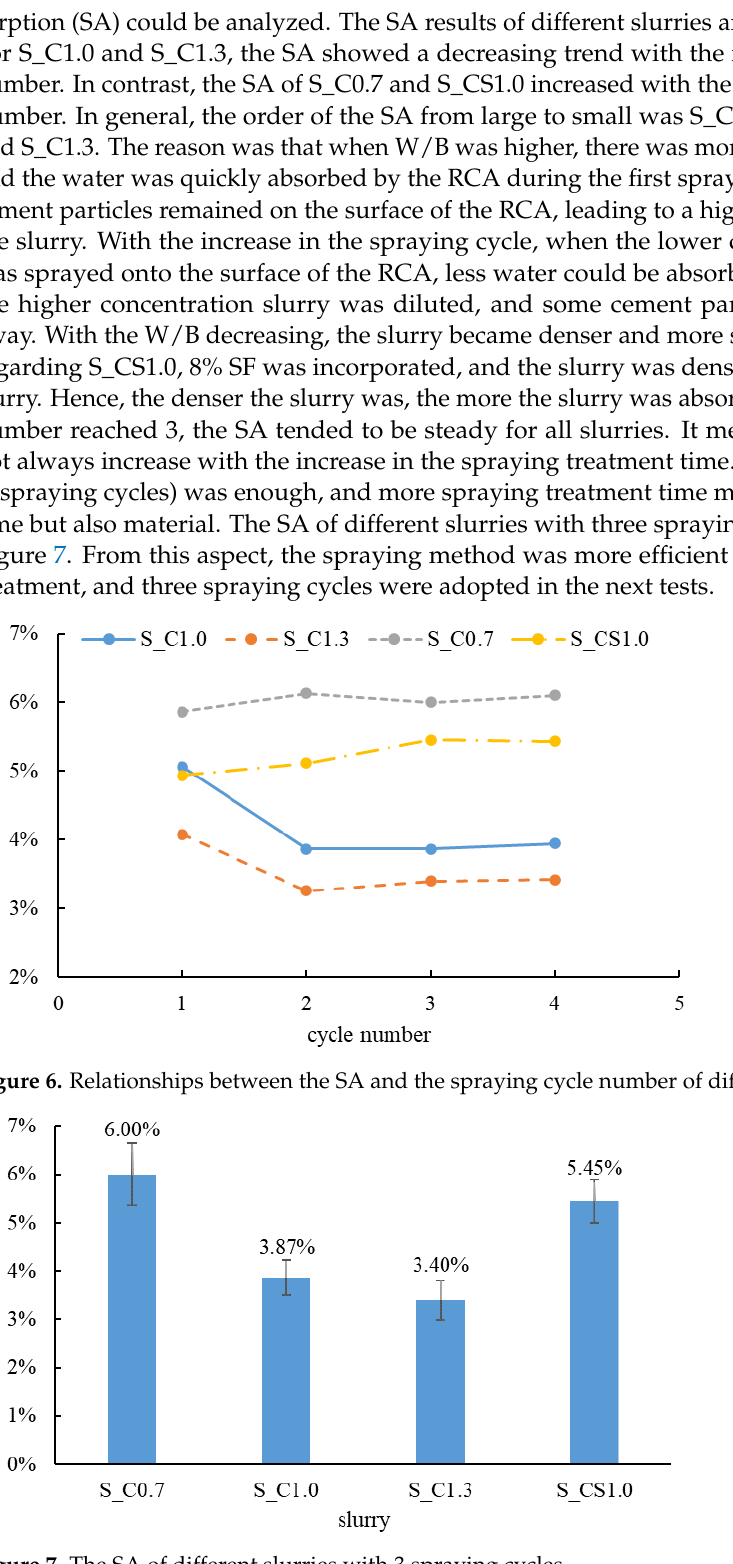
Figure 7. The SA of different slurries with 3 spraying cycles.